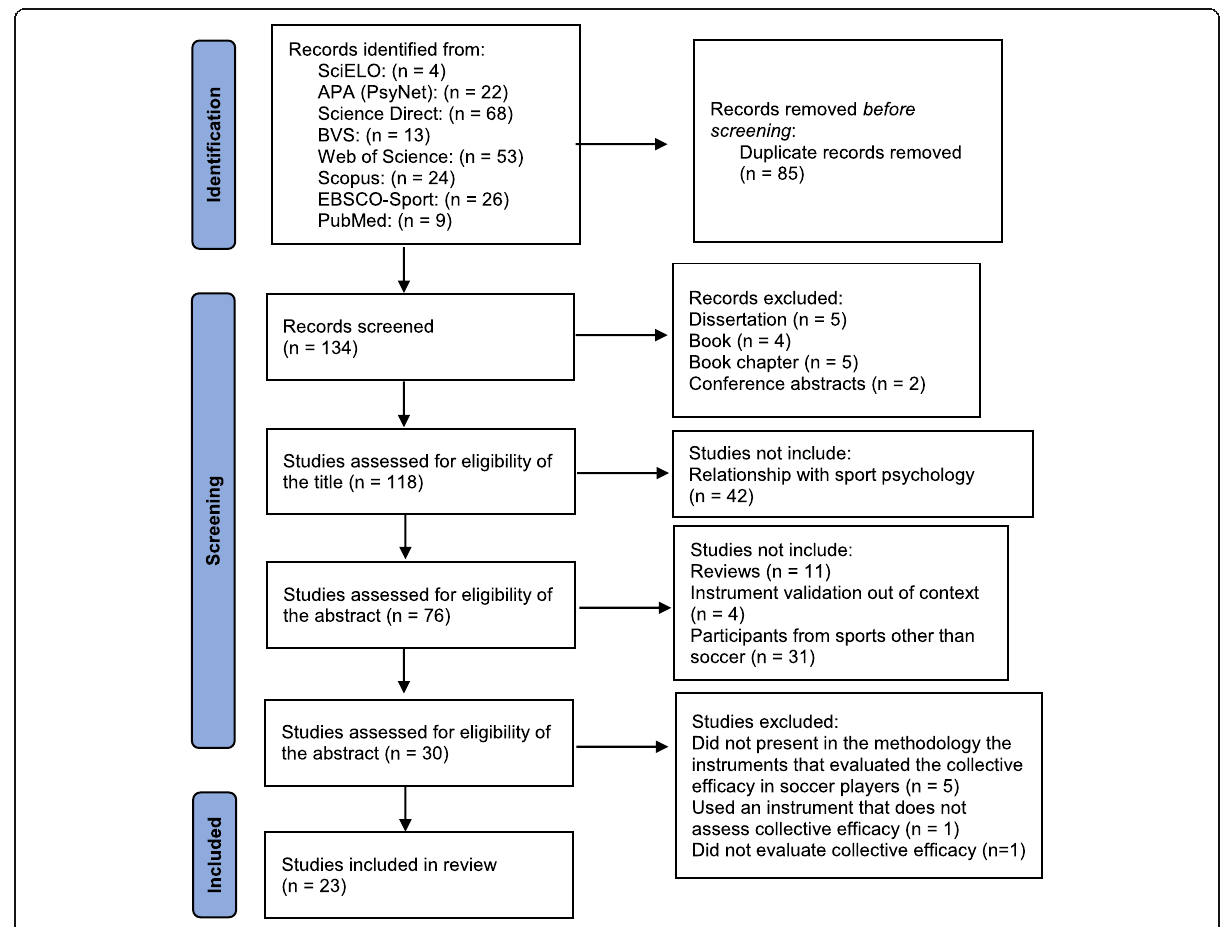
Fig. 1 PRISMA diagram describing the selection process of the reviewed